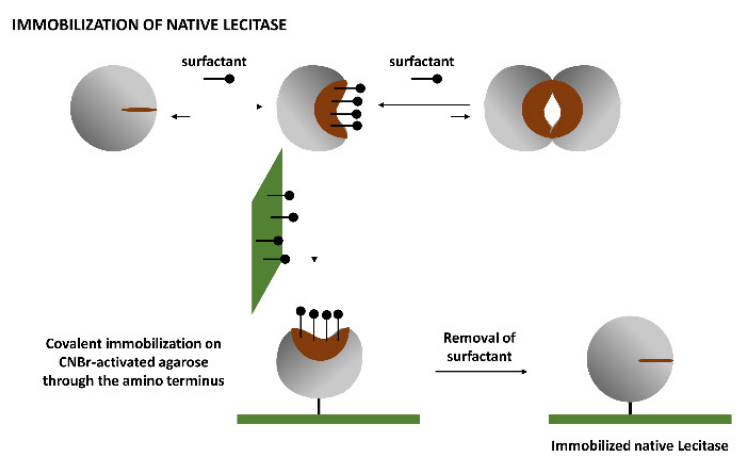
Figure 3. The immobilization mechanism of the isolated close structure of Lecitase. The hyperac- tivated, isolated form becomes predominant in the presence of a surfactant (CTAB). This structure was immobilized by one-point covalent immobilization on CNBr-activated agarose at pH 8.5 for 15 min at 4 °C. After immobilization, the surfactant was removed to form the immobilized closed struc- ture of the enzyme.